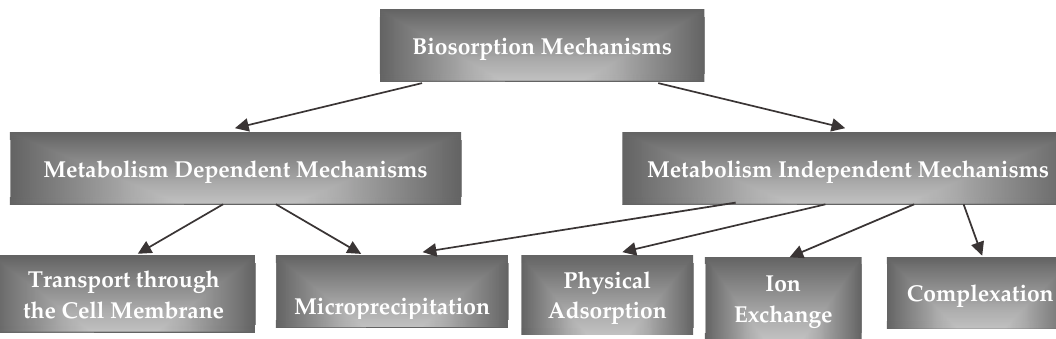
Figure 4. Biosorption mechanisms.